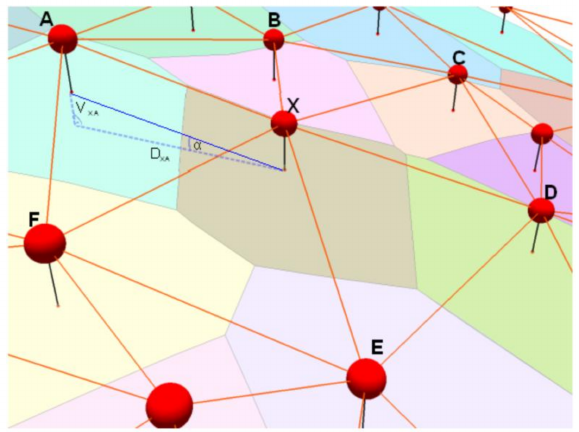
Figure 2. Example of outlier point evaluation procedure. V XA means vertical difference and D XA means horizontal difference between tested points X and A. These two variables define angle α .